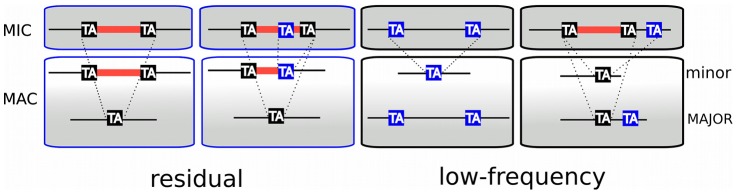
TA-indels are produced by IES excision errors.Schematic representation of the “residual” and “low frequency” TA-indels that were identified by comparing the MAC draft genome assembly (MAJOR form) with the 13× Sanger sequencing reads used to build the assembly [29]. The TA-indels were identified by one or more reads that differed from the assembly (minor form). The residual TA-indels were assumed to be the result of occasional failure to excise an IES and the low-frequency TA-indels to result from excision of MAC-destined sequences. Comparison of the genome-wide set of IESs with the TA-indels revealed that many TA-indels result from the use of alternative IES boundaries situated inside the corresponding IES in the case of residual TA-indels and outside the IES in the case of low-frequency TA-indels. In the schema, TA dinucleotides in black boxes are bona fide IES boundaries while TA dinucleotides in blue boxes are alternative IES boundaries.